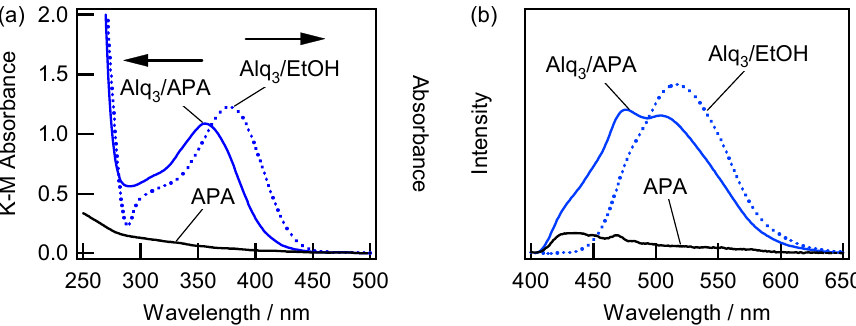
Figure 4. ( a ) Absorption and ( b ) fluorescence spectra obtained for the Alq 3 /EtOH (1 mM) and Alq 3 /APA systems (pure APA was used as control). The APA was prepared under conditions (v). The excitation wavelength was 350 nm.